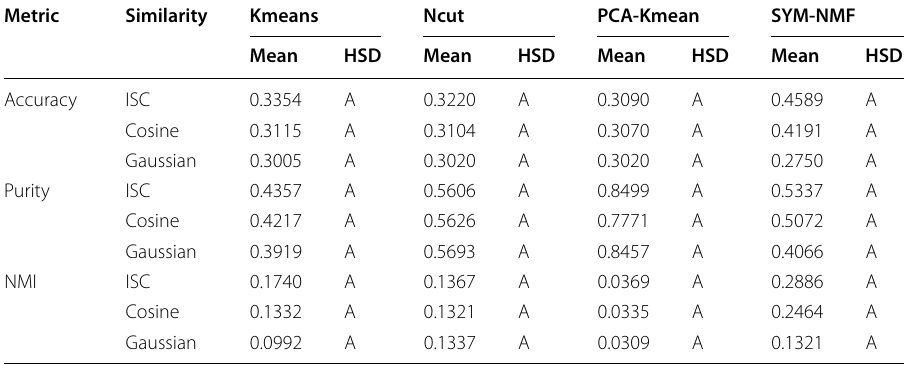
Table 10 Performances of the similarity measures using clustering learners averaged across all data sets Metric